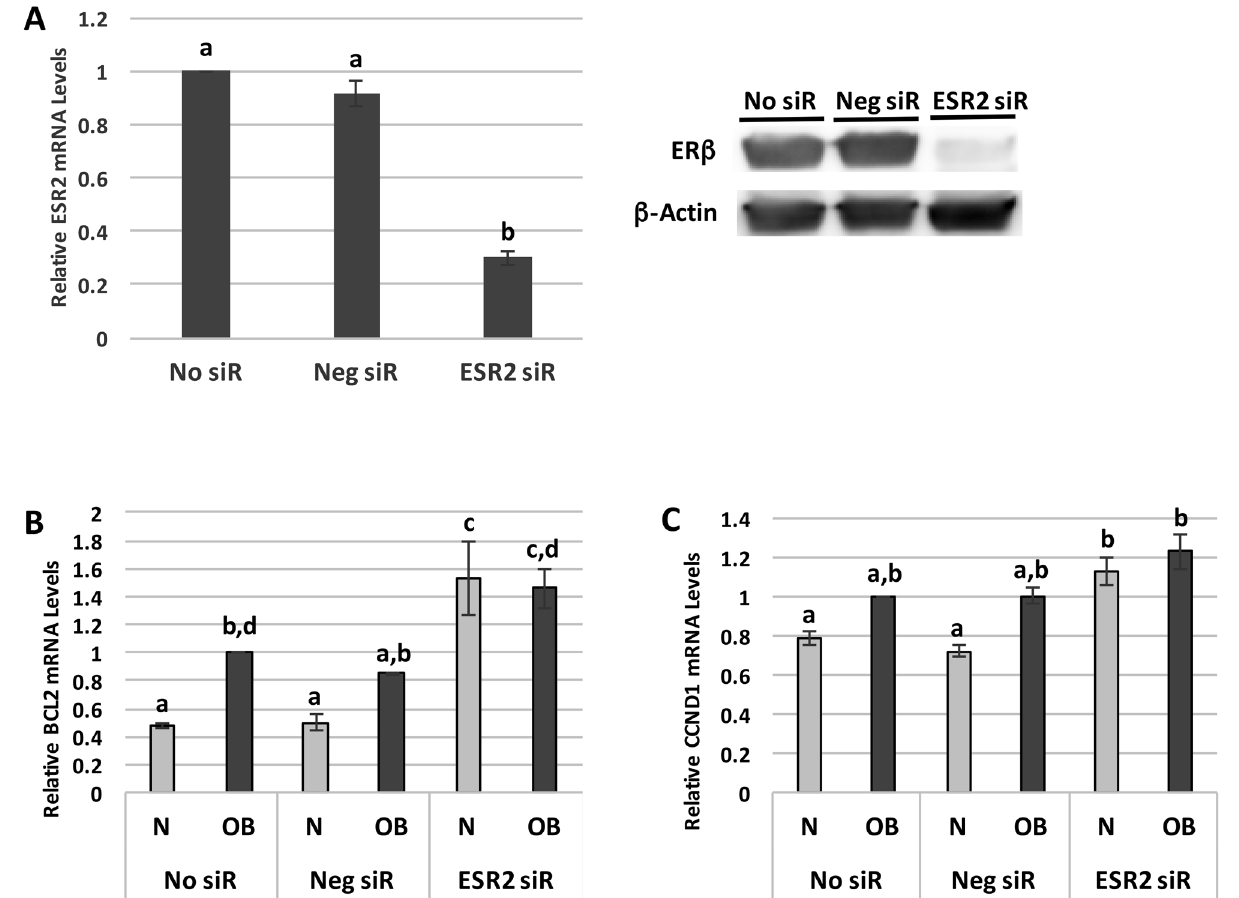
Fig 2. Obesity-associated systemic factors modulate expression of the ER β target genes BCL2 and CCND1 . (A) ESR2 mRNA and ER β protein levels, measured by quantitative RT-PCR and western blotting respectively, in SKBR3 cells without transfection (No siR) or following transfection with a